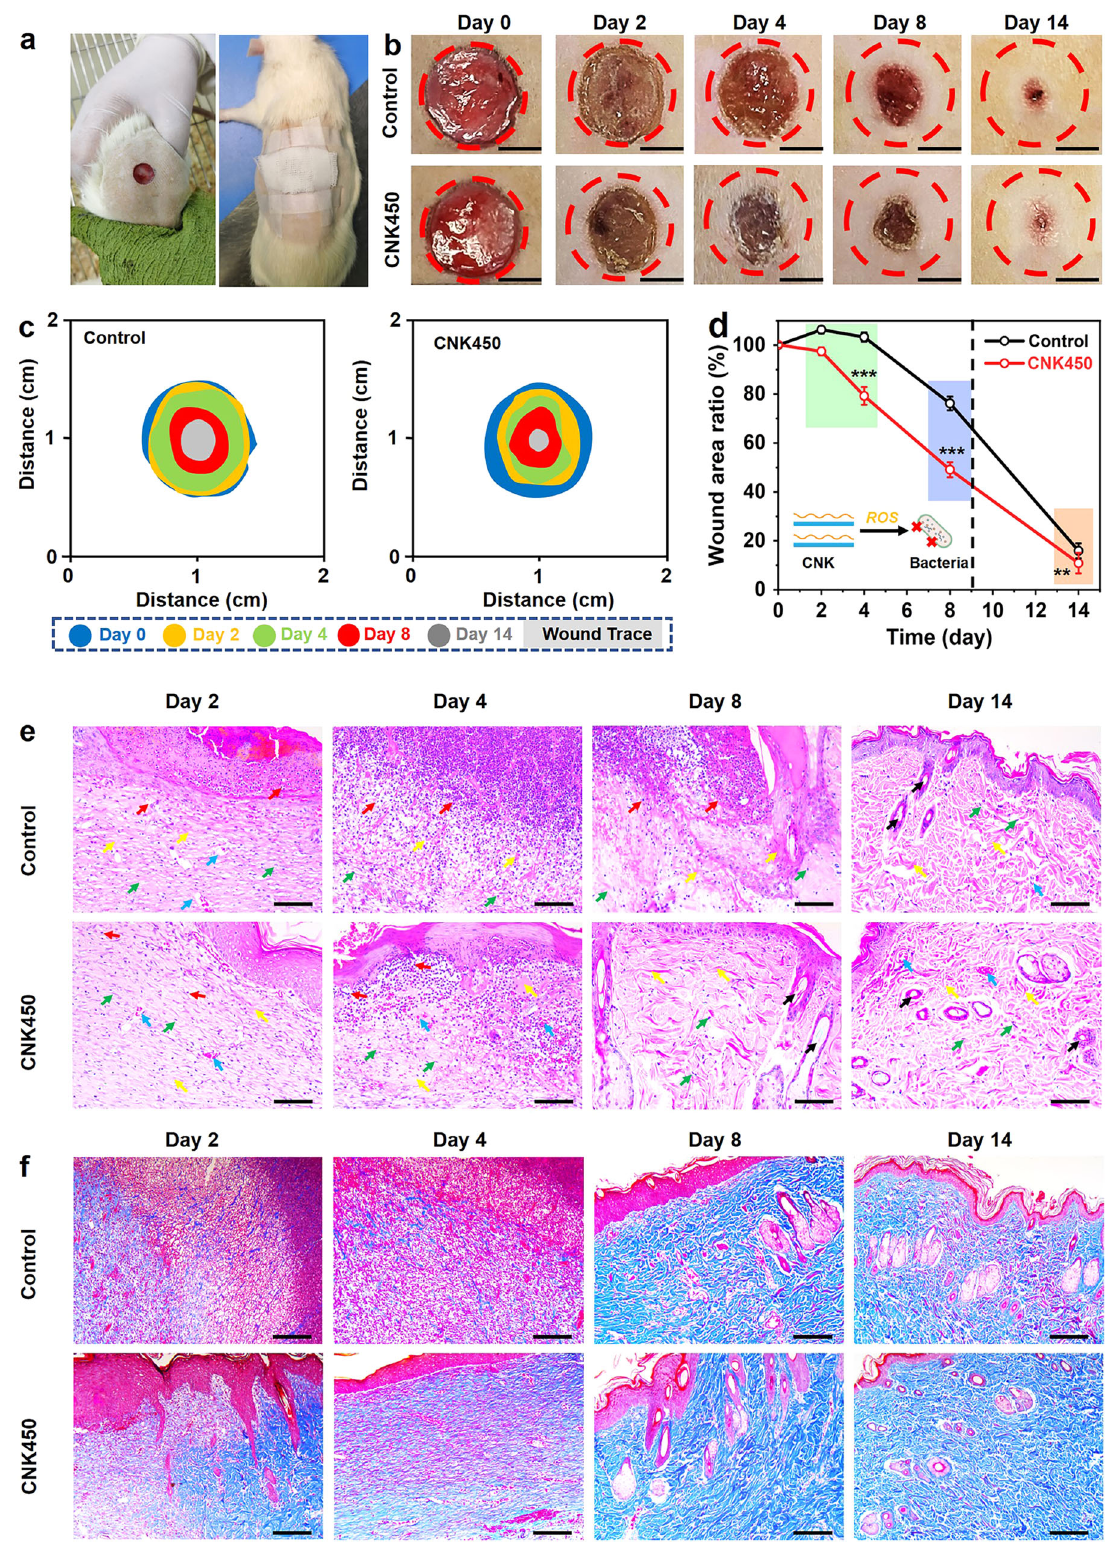
Fig. 5 In vivo anti-infection and bacteria-infected wound healing. a Skin wound images. b Representative wound images of wounds in the group of CNK450 and the control group without sample treatment from day 0 to day 14. Scale bar: 10 mm. c Wound traces at different periods. d Evolution of wound area ratio at different days for each group. The error bars showed standard deviation ( n = 3), * p < 0.5, ** p < 0.01 or *** p < 0.001 (one-way ANOVA followed by Bonferroni ’ s multiple comparison test). The inset image represents the CNK release ROS to kill signi fi cantly bacteria during the period as indicated by the dash line. e HE staining and f Masson staining on day 2, 4, 8 and 14 of the newly regenerated skin tissues for each group. Scale bar: 100 μ